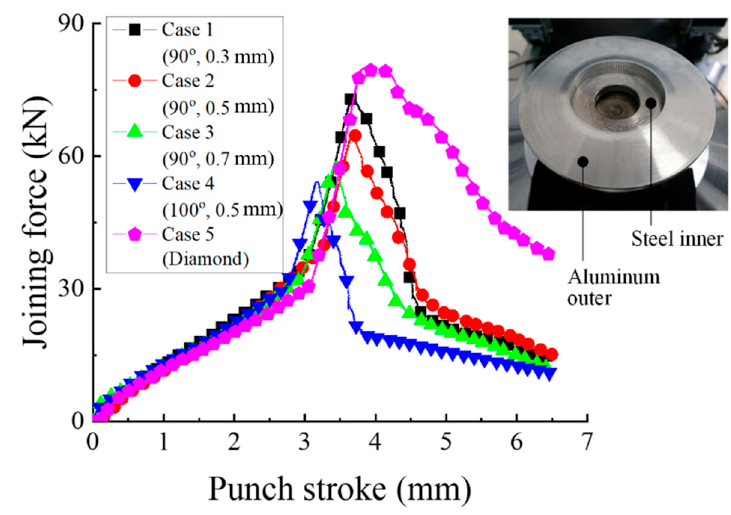
Figure 15. Joining force vs. punch stroke.